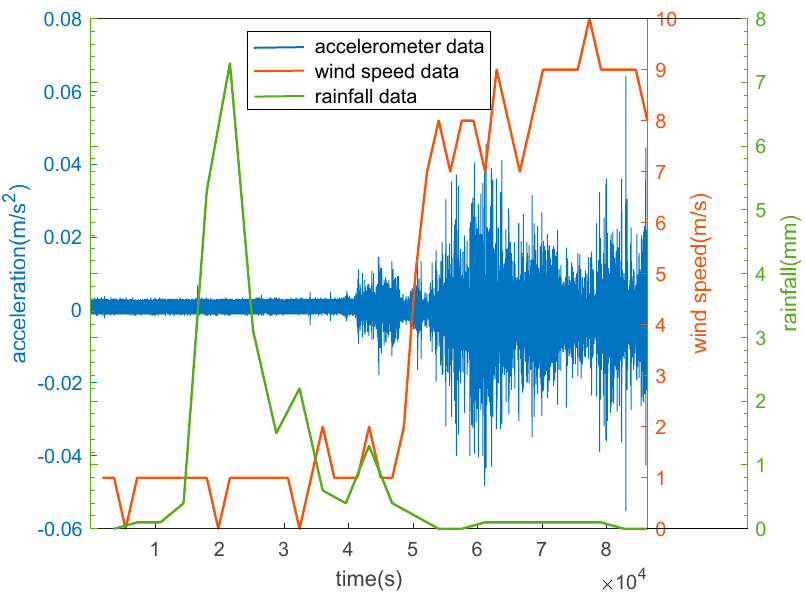
Figure 10. Comparison of the correlation between the acceleration, wind speed, and rainfall data on extreme weather.